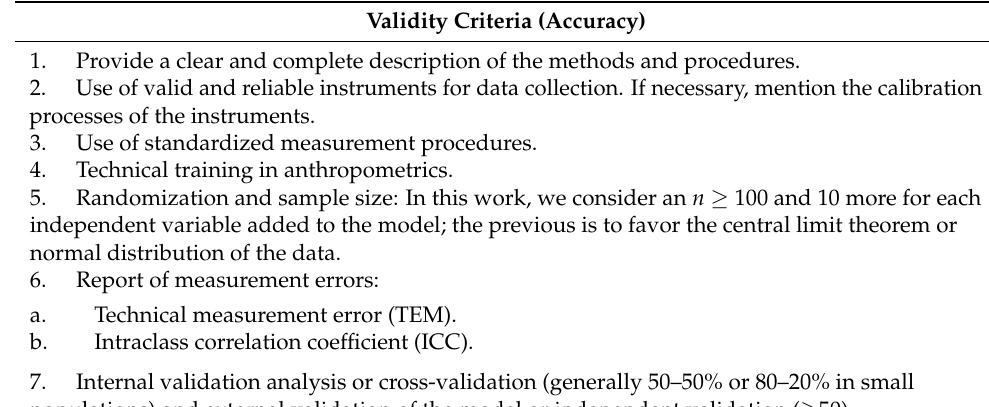
Table 2. Criteria to evaluate the validity and reliability of the regression